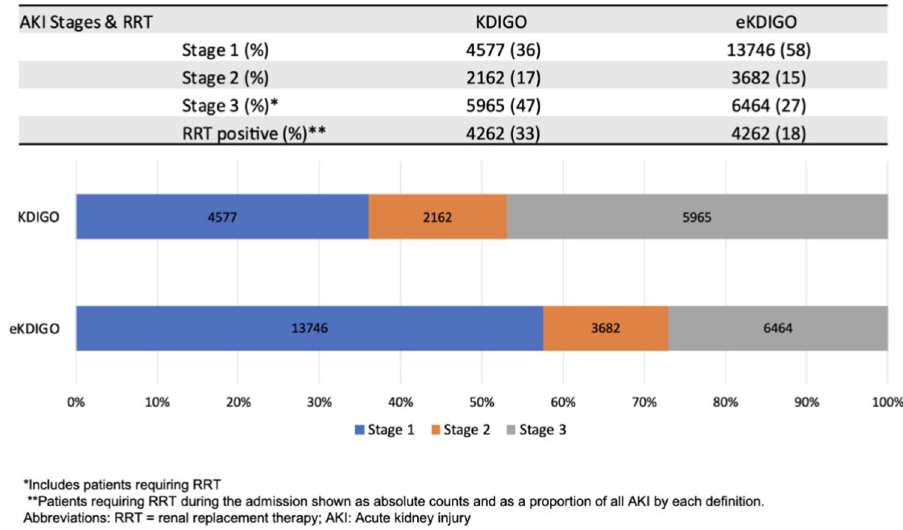
Fig 3. Staging of AKI using KDIGO and eKDIGO definitions. AKI, acute kidney injury; eKDIGO, extended KDIGO; KDIGO, Kidney Disease Improving Global Outcomes; RRT, renal replacement therapy.